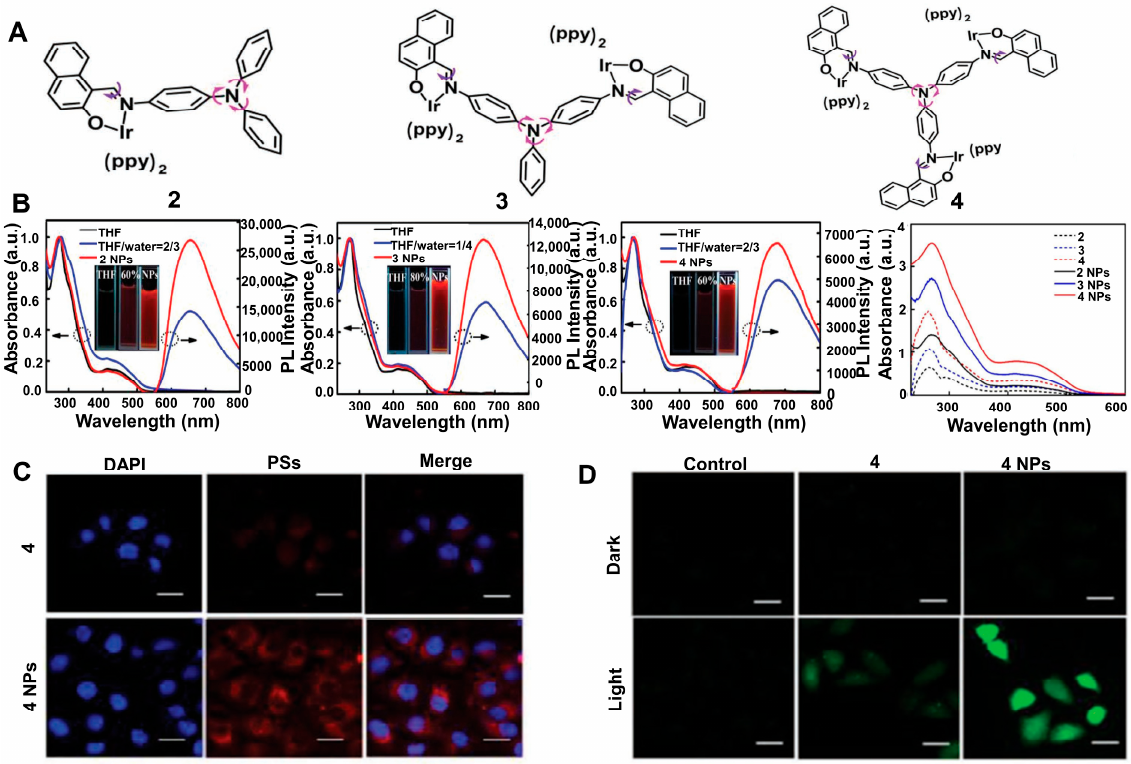
Figure 3 . ( A ) Molecular structure of 4 , 5 and 6 . ( B ) UV–vis absorption spectra and emission spectra of 4 , 5 , 6 and corresponding NPs. ( C ) CLSM images of Hela cells in the presence of 6 and 6 NPs. ( D ) Confocal fluorescence images for the detection of 1 O 2 generation in Hela cells treated with 6 and 6 NPs. Reprinted with permission from [49] , copyright 2019,